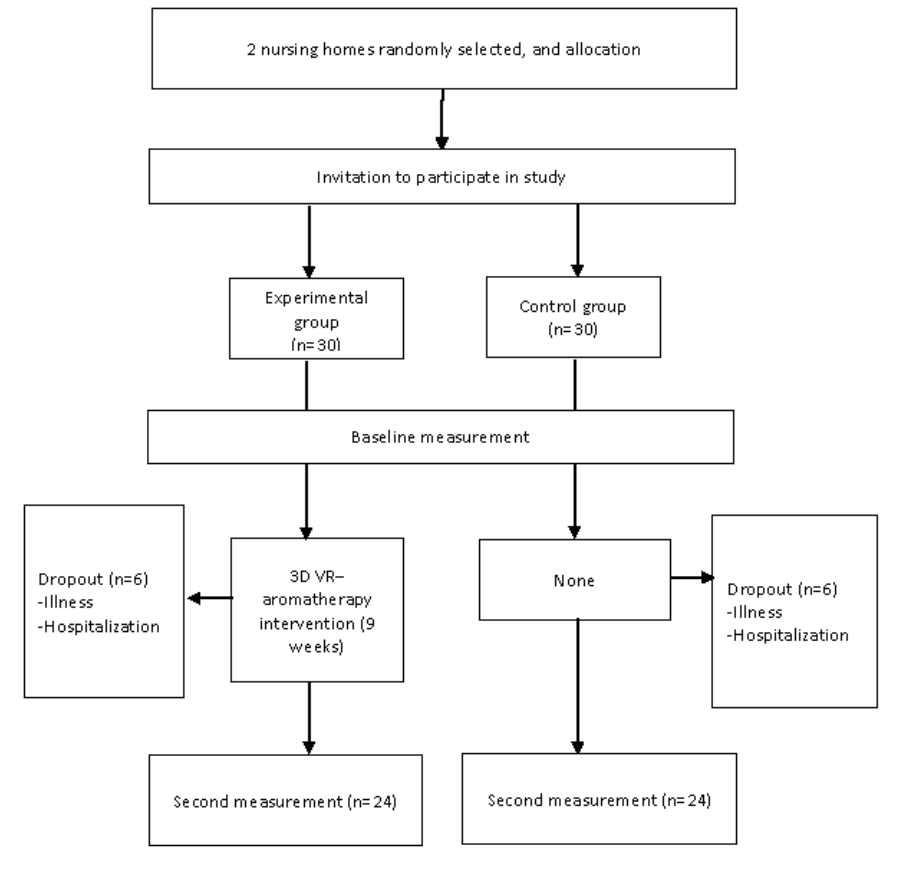
Figure 1. Flowchart of participant enrollment and assessment. 3D: 3-dimensional. VR: virtual